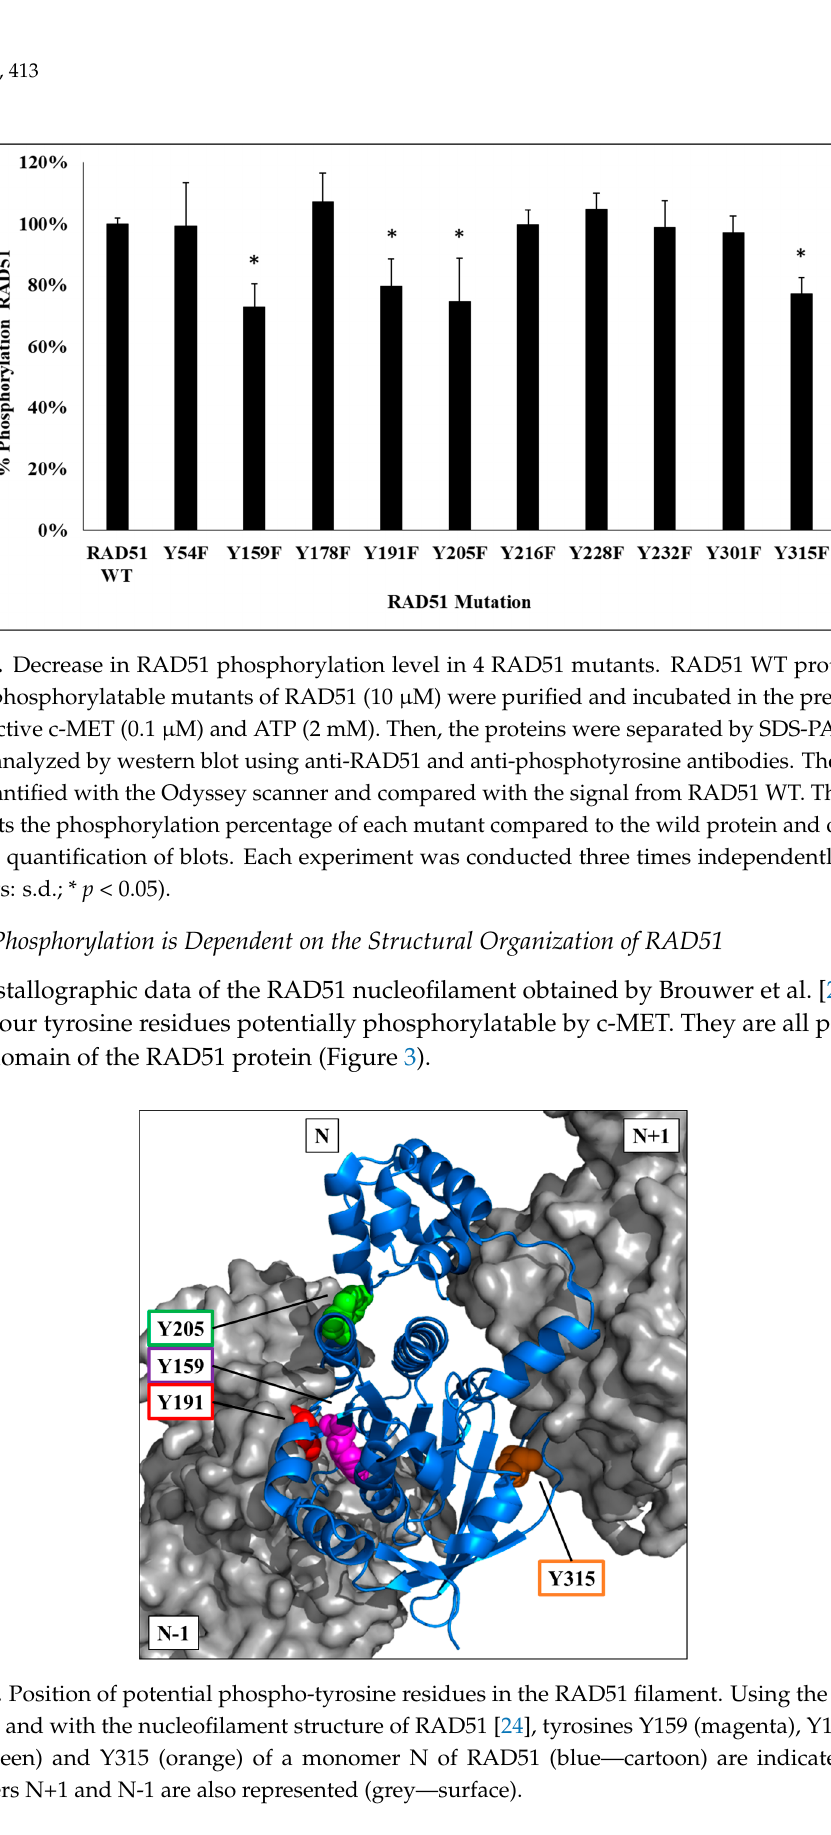
Figure 3. Position of potential phospho-tyrosine residues in the RAD51 filament. Using the PyMOL software and with the nucleofilament structure of RAD51 [24], tyrosines Y159 (magenta), Y191 (red), Y205 (green) and Y315 (orange) of a monomer N of RAD51 (blue—cartoon) are indicated. The monomers N+1 and N-1 are also represented (grey—surface).